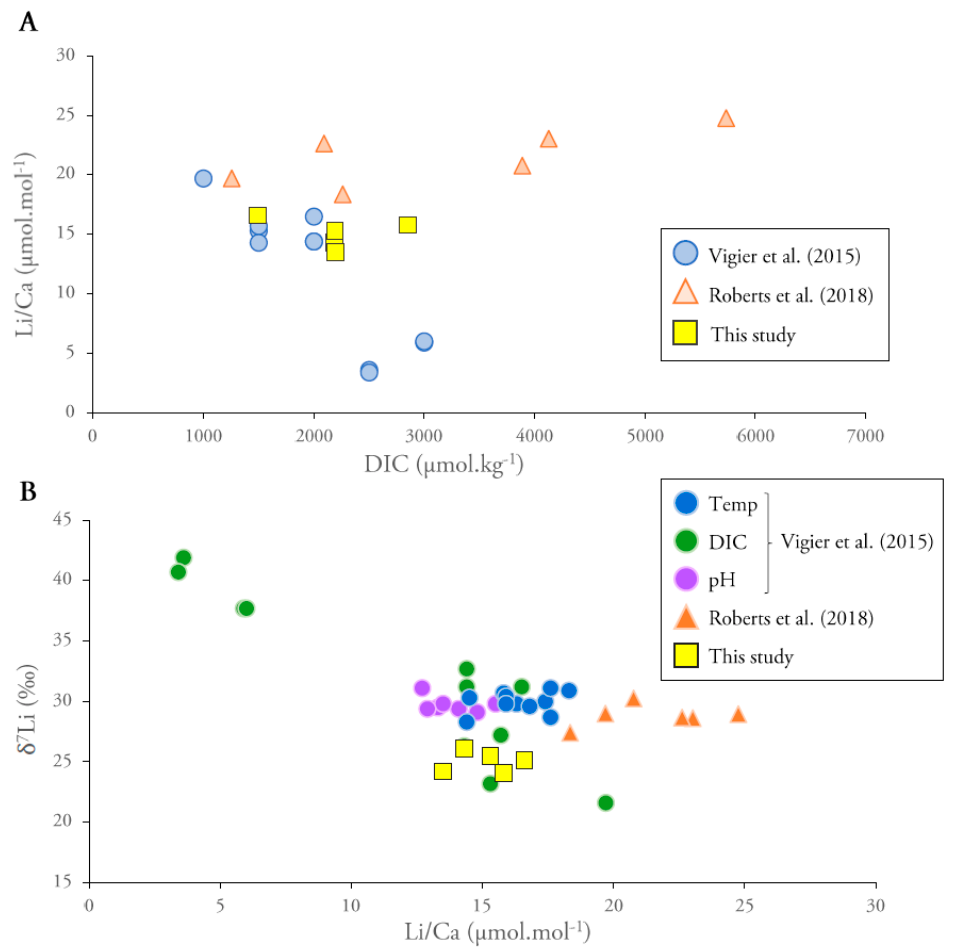
Figure 6. Comparison with previous studies on species from the Amphistegina genus [21,22]. ( A ) Li/Ca ratios versus DIC and ( B ) δ 7 Li values versus Li/Ca ratios. The three sets of experiments from Vigier et al. (2015) with varying temperature, DIC, and pH are presented.